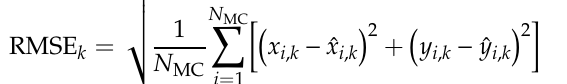
Figure 7. Power allocation ratio.